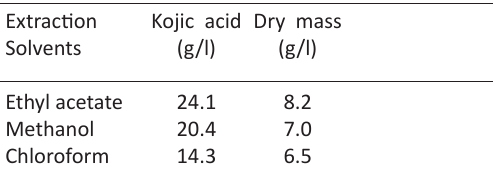
Table 2. Extraction solvents for the biosynthesis of kojic acid and dry mass by A. flavus